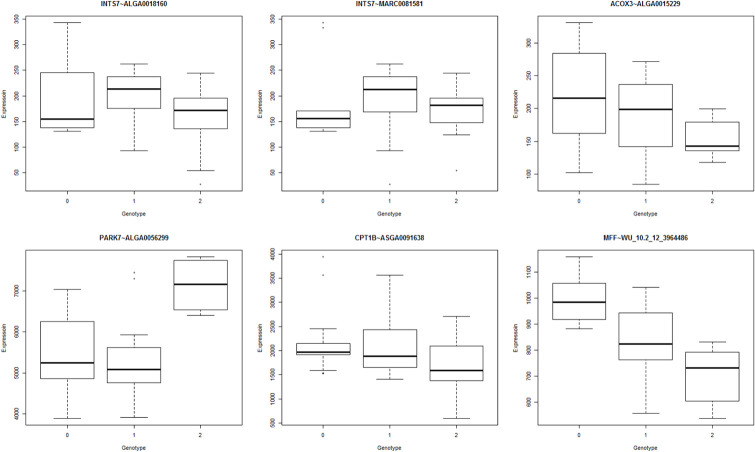
Top linear trans eQTLs.Boxplot of the top 6 trans-eQTLs from linear analysis. Comparing with the summary from Table 1, it seemed unexpected that the top left boxplot was the most significant eQTL. Overall, the 3rd and the 6th ranked eQTLs look visually more significant. This was because the genotypes and expression values were not corrected in relation to the model covariated and factors.